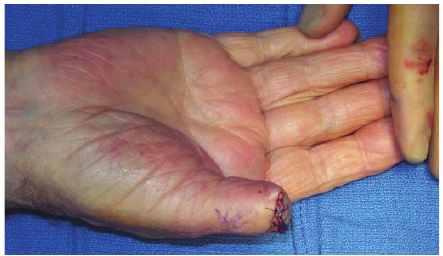
Figure 3. After interphalangeal joint level amputation (patient from Figure